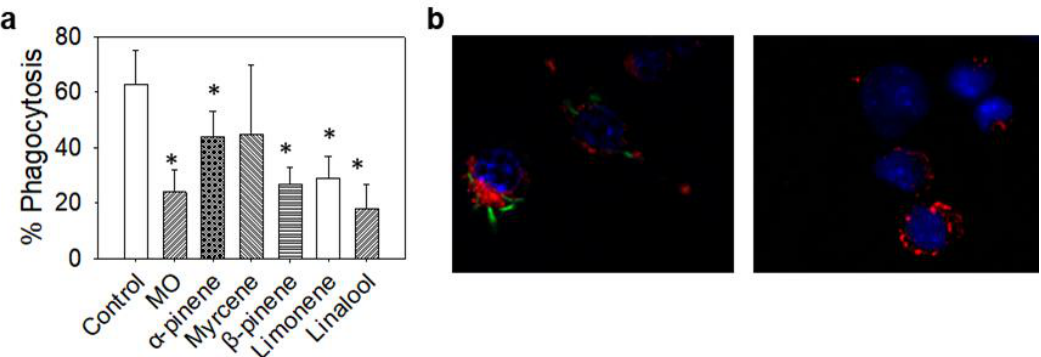
Figure 5. Effect of non-toxic concentrations of MO or its major constituents on the phagocytosis rate of RAW264.7 cells. CFSE-stained L. casei (green) was used as an in vitro pathogen model. RAW264.7 nuclei were stained with Hoechst 33342 (blue) and their cytoplasm with CellBrite (red). Cells were co-cultured with L. casei in the presence of MO or its major constituents for 4 h. Control cells were exposed to L. casei in plain medium. ( a ) %Phagocytosis rate of L. casei bacteria by RAW264.7 cells calculated as percentage of phagocytosing to non-phagocytosing cells. Data are representative of three independent experiments and are presented as mean ±SD. ( b ) Fluorescence microscopy images of control RAW264.7 cells phagocytosing L. casei bacteria (left) and MO-treated RAW264.7 cells exhibiting limited phagocytic activity. Asterisks indicate statistically significant difference compared to control (one way ANOVA, p ≤ 0.05 ).